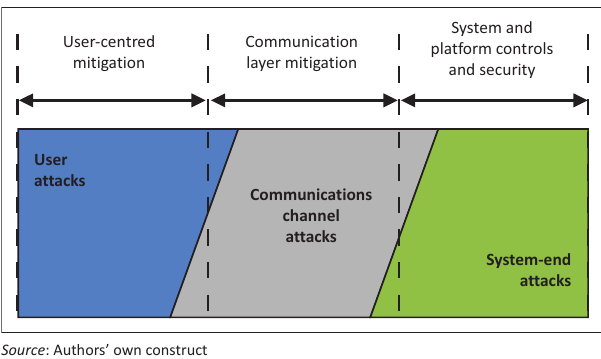
FIGURE 1: Attacks to discover passwords can be aimed at various